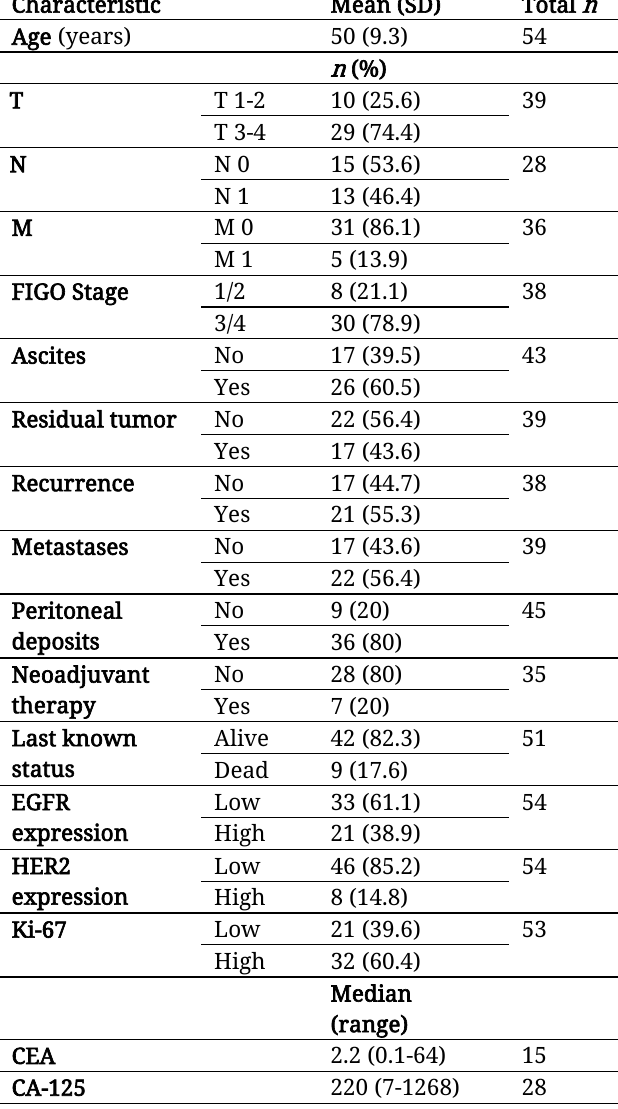
CEA: Carcinoembryonic antigen, FIGO: International Federation of Gynecology and Obstetrics, SD: Standard